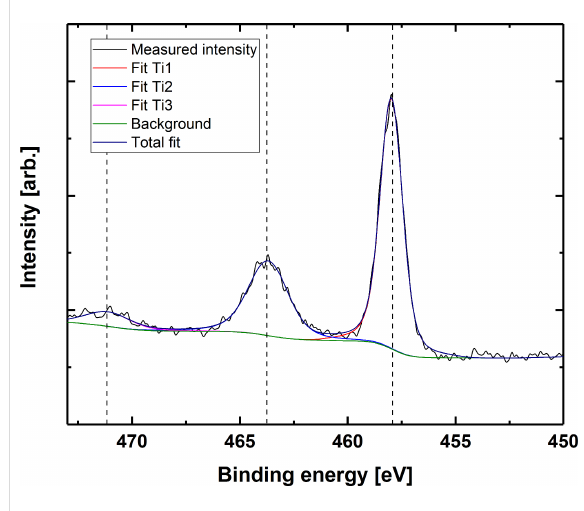
Figure 12: Titanium 2p peak for a hybrid film based on thymine. The binding energy is corrected by calibrating with respect to adventitious carbon (284.8